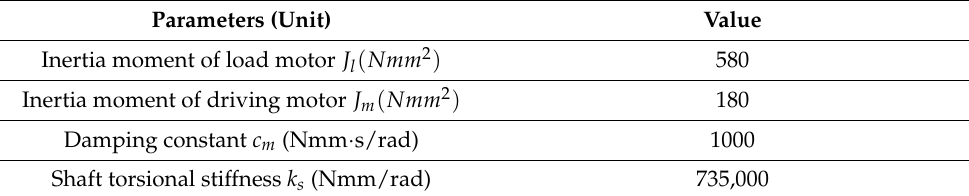
Table 1. Parameters for the estimation of torsional